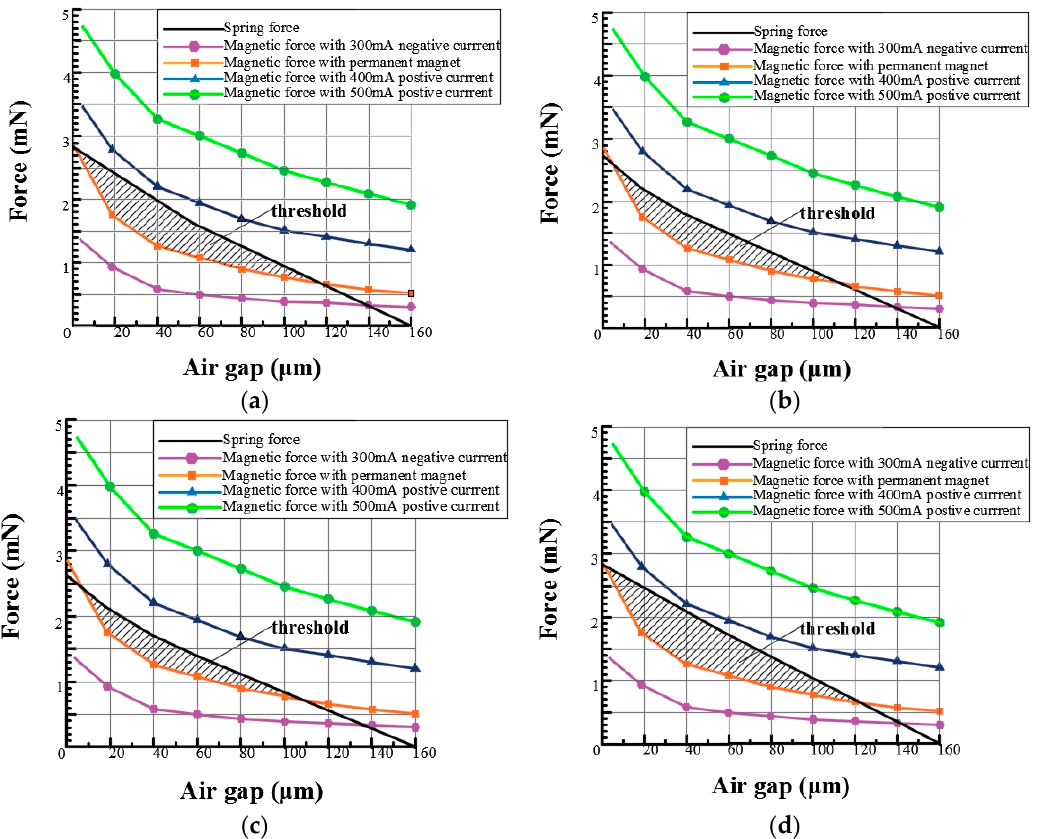
Figure 5. Matching diagram of elastic force and magnetic force for microsprings with four topology structures. ( a ) U-type; ( b ) N-type; ( c ) L-type; ( d ) W-type.